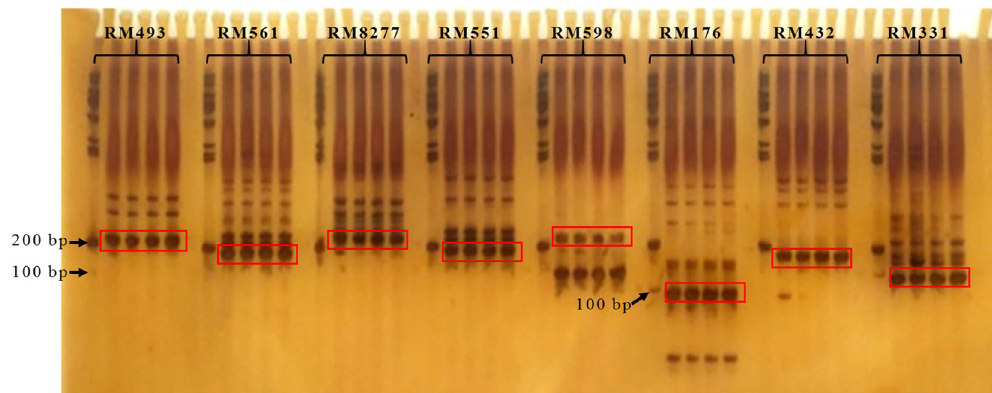
Figure 5. Parts of gel electropherograms profile of wild type and mutant lines. For each SSR maker, lanes from left to the right are: M, W, M1 and M2 . M: DNA ladder. M: DNA ladder 1000; W: wild type; M1 and M2 : low filled grain percentage mutants from 140 V, 48 h treatment and 2 from 140 V, 48 h treatment, respectively; M3 : abnormal hull mutant from 110 V, 48 h treatment. The red boxes indicate the main amplified blots for each SSR, and the whole gel electropherograms profile and the original gels are presented in Supplementary Figure S2.